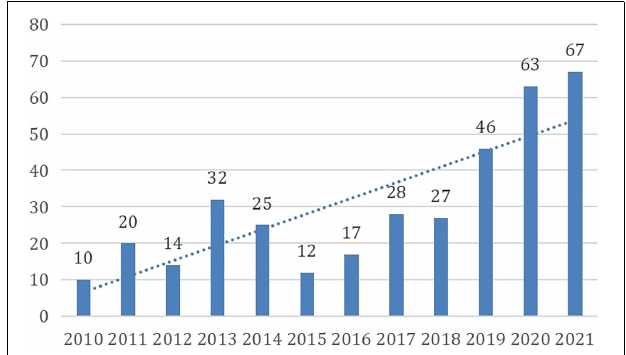
FIGURE 2 | Yearly publications on English-speaking teaching and learning